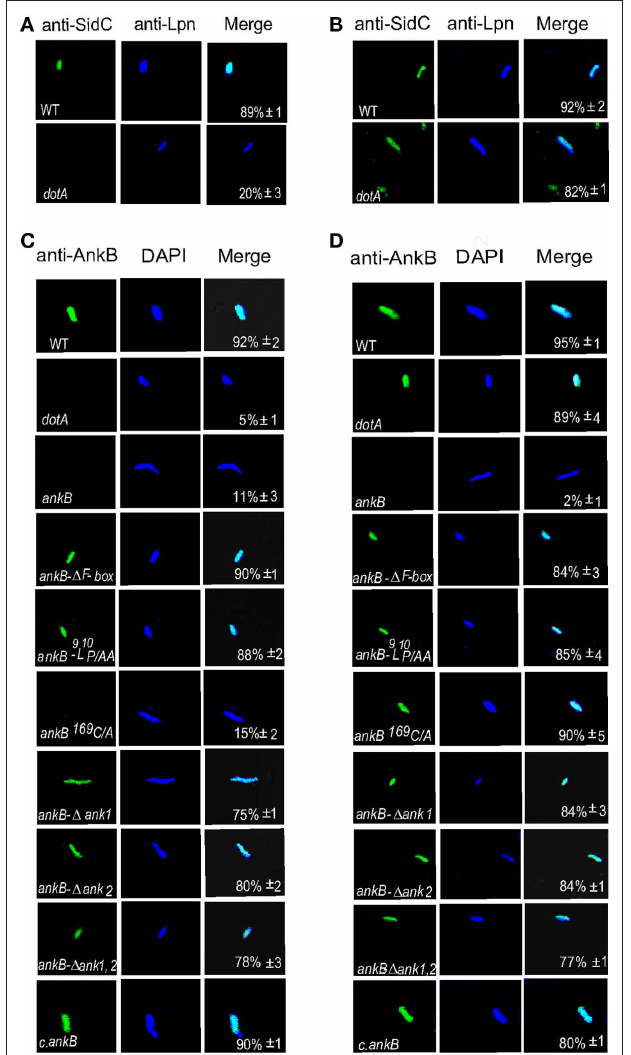
FIguRe 6 | The two ANK domains are dispensable for anchoring AnkB to the cytosolic face of the LCV membrane. The infection was performed for 1 h and the cells were lysed at 2 h post-infection to purify the LCVs. Semi-purified LCVs were analyzed by confocal microscopy. Representative confocal microscopy images that show location of AnkB at the cytosolic face of LCVs. (A) The LCVs were probed with anti-SidC prior to permeabilization of membranes (green). After permeabilization of membranes, the LCVs were stained with DAPI to visualize L. pneumophila (Lpn blue). (B) The LCVs were permeabilized then labeled with anti-SidC and DAPI stain. (C,D) Integrity of the membrane of semi-purified LCVs from D. discoideum was verified by (C) labeling with anti-AnkB antibodies (green) prior to permeabilization of the LCVs. After permeabilization, the LCVs were labeled with anti-Lpn antibodies (blue) within the LCVs. (D) The LCVs were permeabilized followed by labeling with anti-AnkB and anti-Lpn antibodies (blue). Quantification is shown in the merged panels, where the numbers represent the percentage + SD of LCVs that showed localization of AnkB to the cytosolic face of the LCV membrane. Quantitation was based on analyses of 100 LCVs from different coverslips. The data are representatives of three independent experiments.